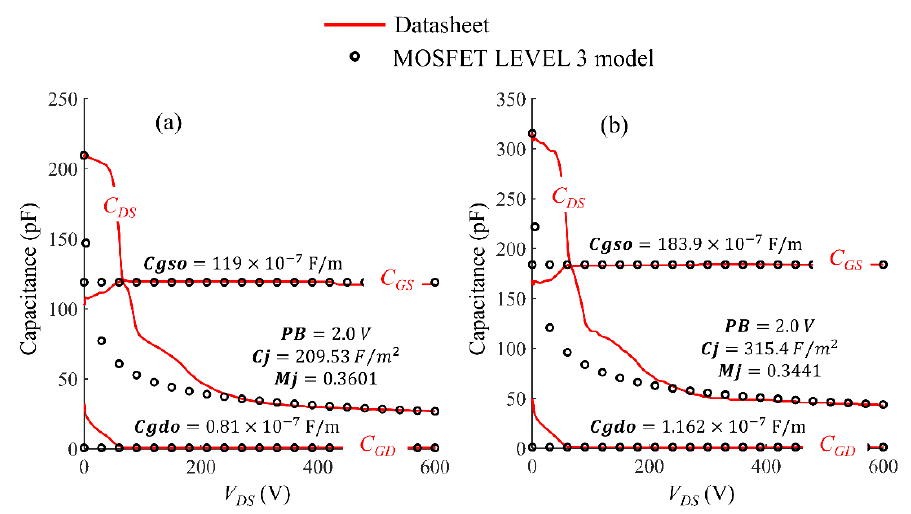
Figure 5. Verification of dynamic characteristics of MOSFET LEVEL 3 model for ( a ) GS66504B and ( b ) GS66506T.